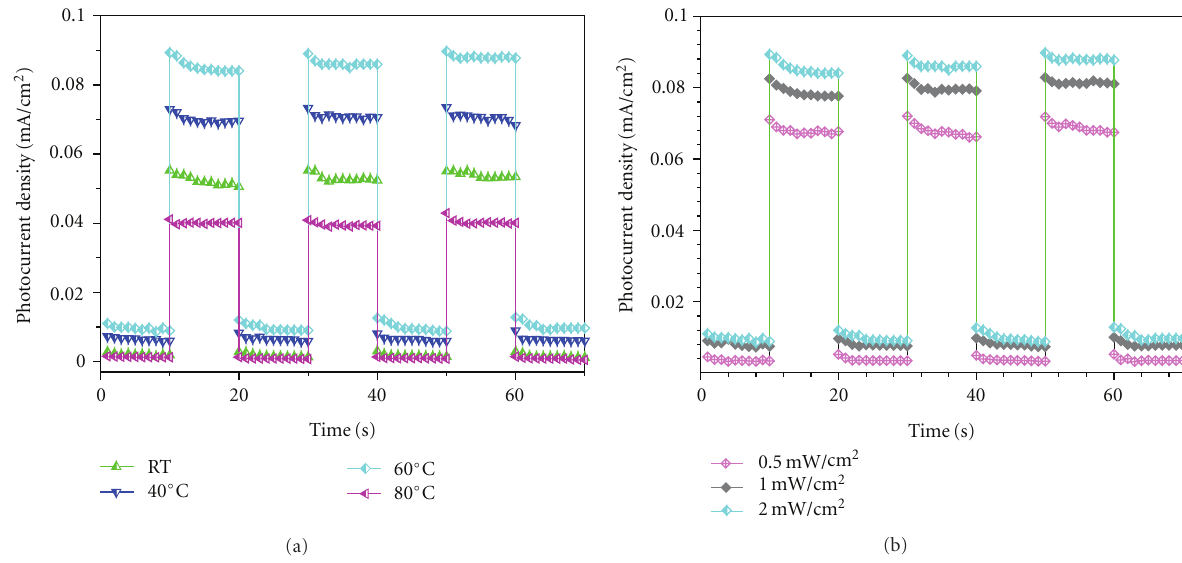
Figure 12: Photoresponse as a function of time at 0V of ITO/PEDOT:PSS/PFE:BNDI (3:1) ∗ /Al ∗ : (a) annealed at RT, 40 ◦ C, 60 ◦ C, and 80 ◦ C under 2mW/cm 2 and (b) 60 ◦ C-annealed device under 0.5 mW/cm 2 , 1mW/cm 2 , and 2 mW/cm 2 at 368 nm UV